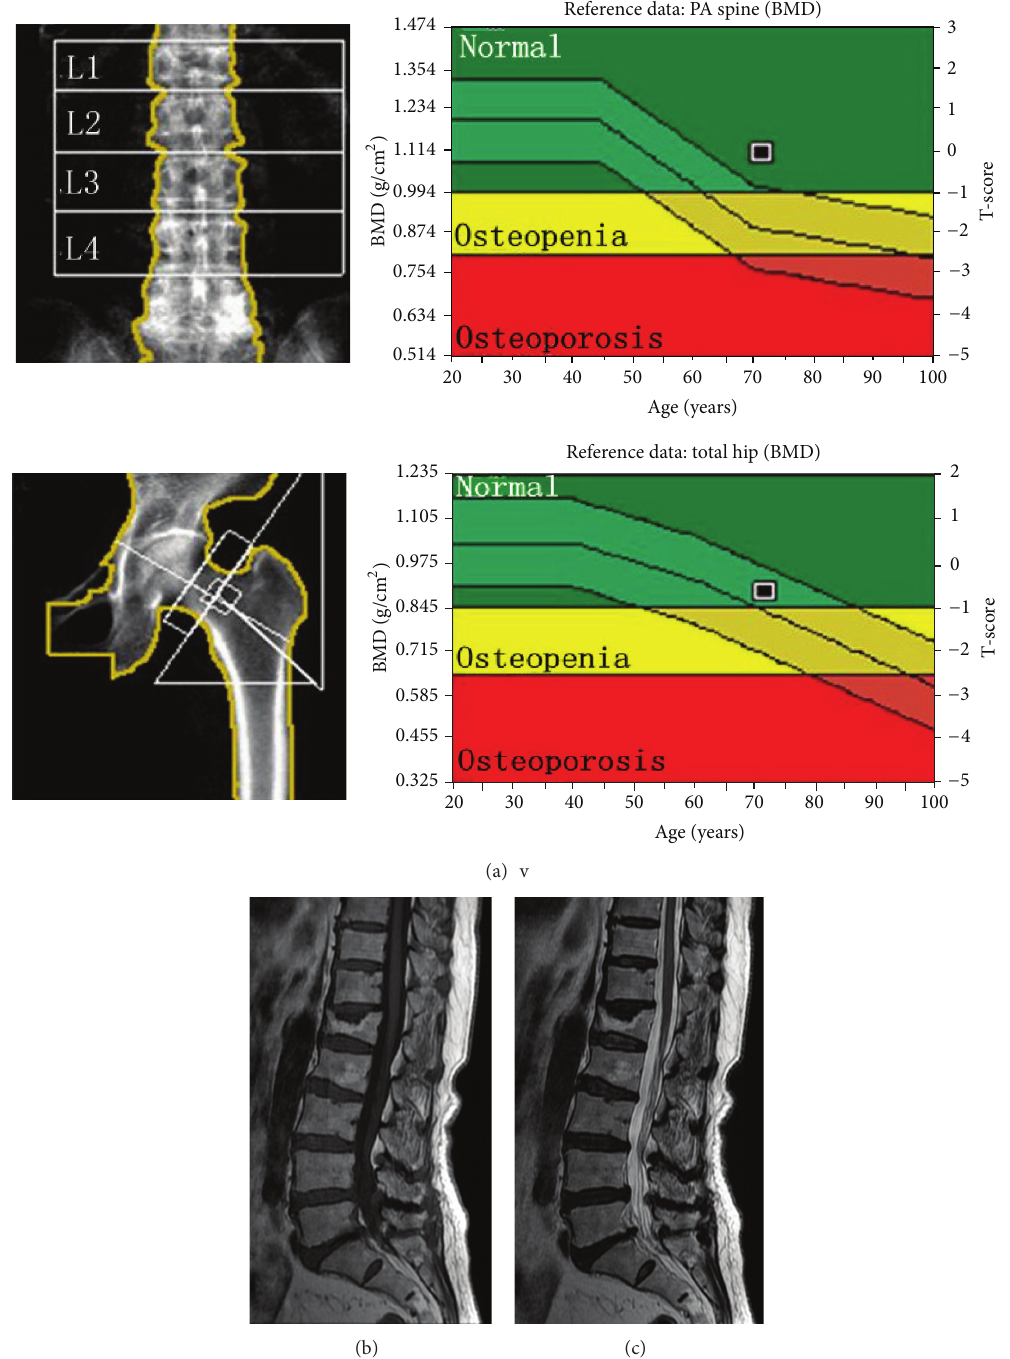
Figure 1: Images obtained from a 71.7-year-old woman whose bone mineral density was found to be normal on dual X-ray absorptiometry. (a) The T-scores for lumbar posteroanterior dual X-ray absorptiometry, the femoral neck, and the total hip were − 0.1, − 0.8, and − 0.7, respectively. The trabecular bone mineral density of L2–L4 was 36.1 mg/cm 3 , and the diagnosis via lumbar quantitative computed tomography was osteoporosis. Sagittal lumbar spine images show two adjacent vertebral fractures with wedging, deformation of the end plates, and degenerative disc disease: (b) T 1 weighted and (c) T 2